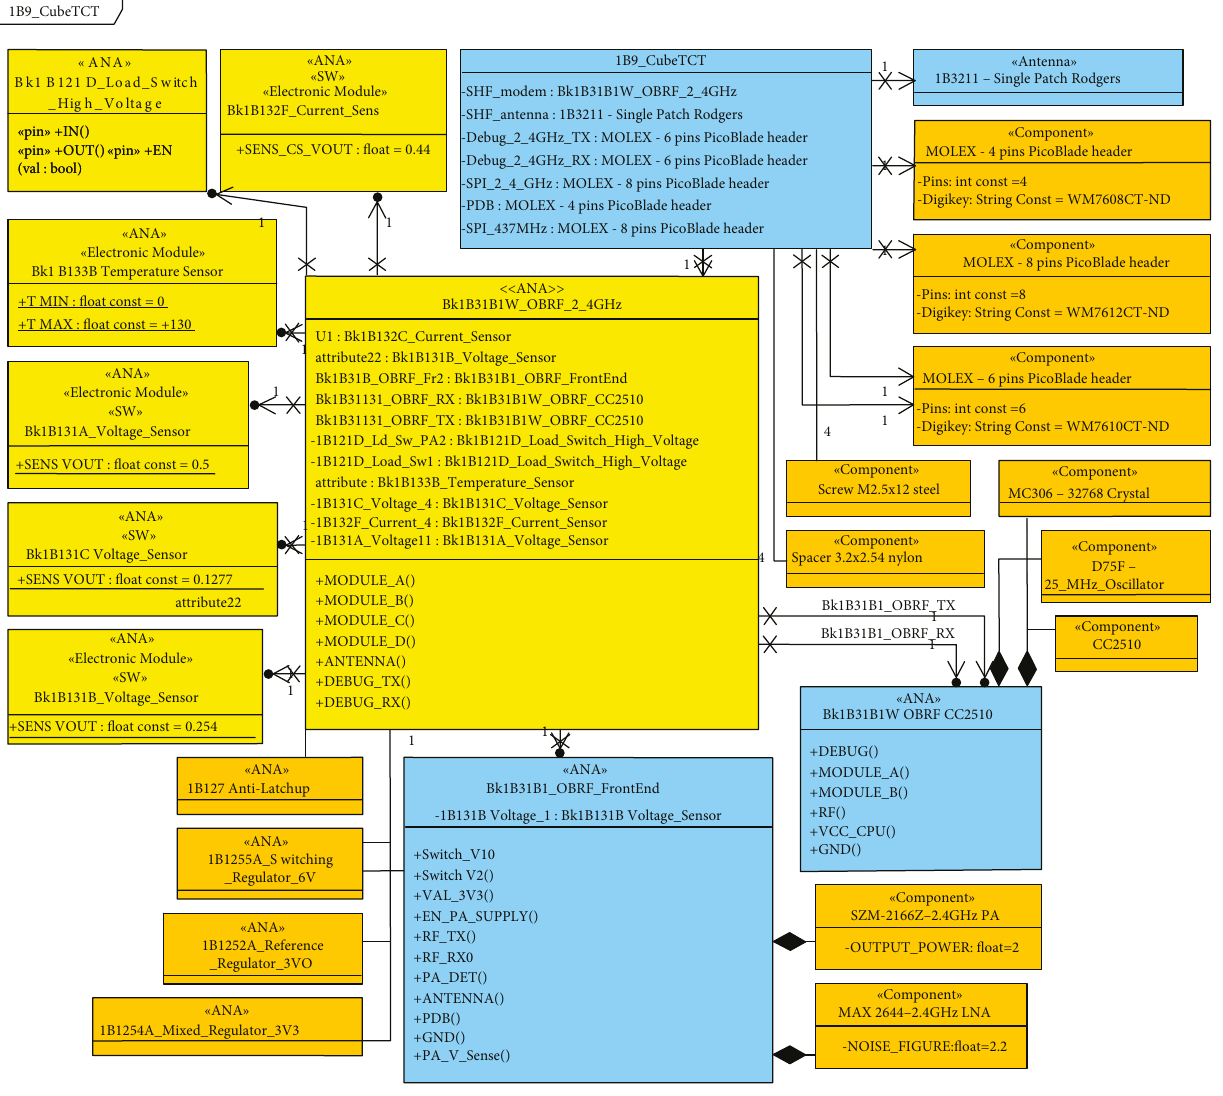
-NOISE_FIGURE:float=2.2Bk1B31B1_OBRF_RXBk1B31B1_OBRF_TX«pin» Figure 1: UML class diagram for 1B9_CubeTCT showing association with all other subclasses and